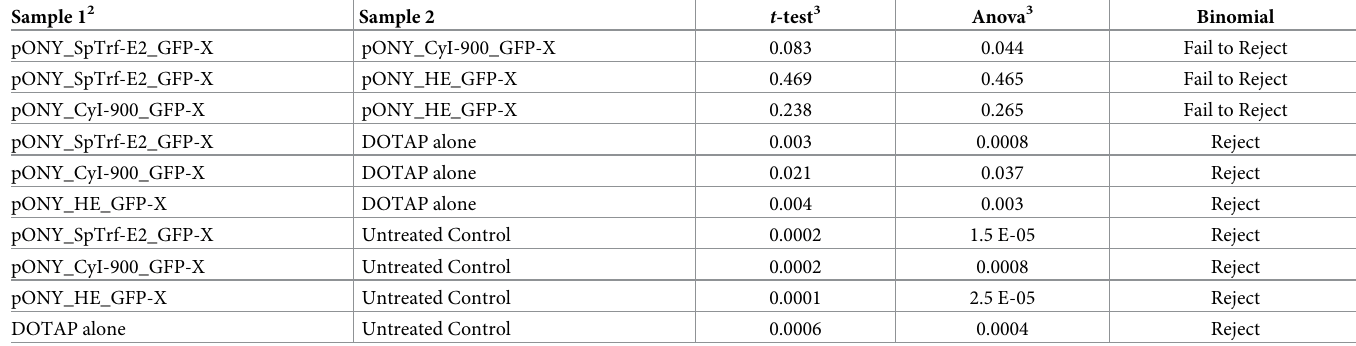
GFP expression (Table 2) for pairs of samples are compared to determine significant difference. 3 p values; p < 0.05 is considered